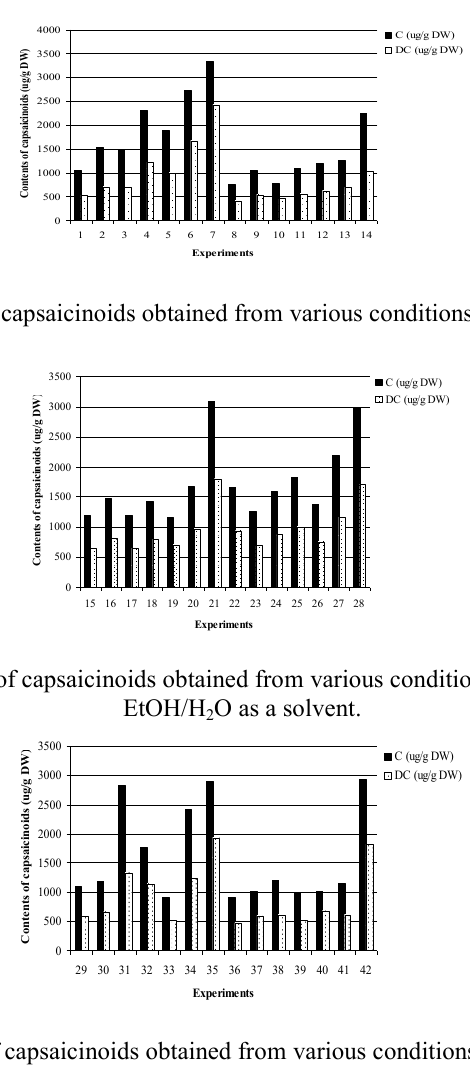
Figure 3. Contents of capsaicinoids obtained from various conditions of ASE using ACN as a